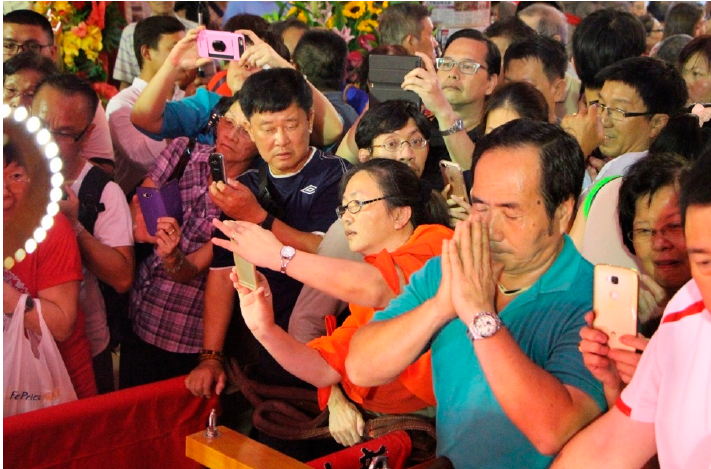
Figure 9. The Combined Acts of Prayer and Photo-taking by Devotees. (Source: Alvin Eng Hui